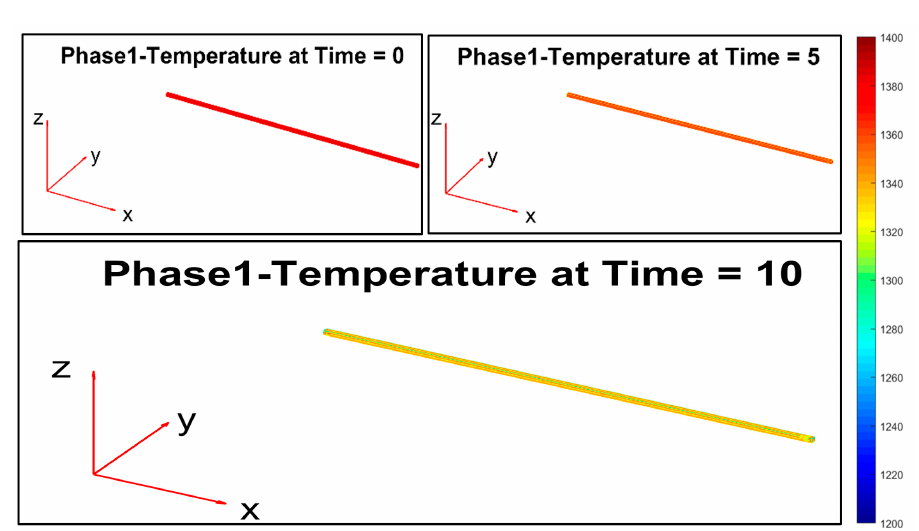
Figure 13. Modelization: phase 1 (movement between the thermal imaging camera and the descaler).